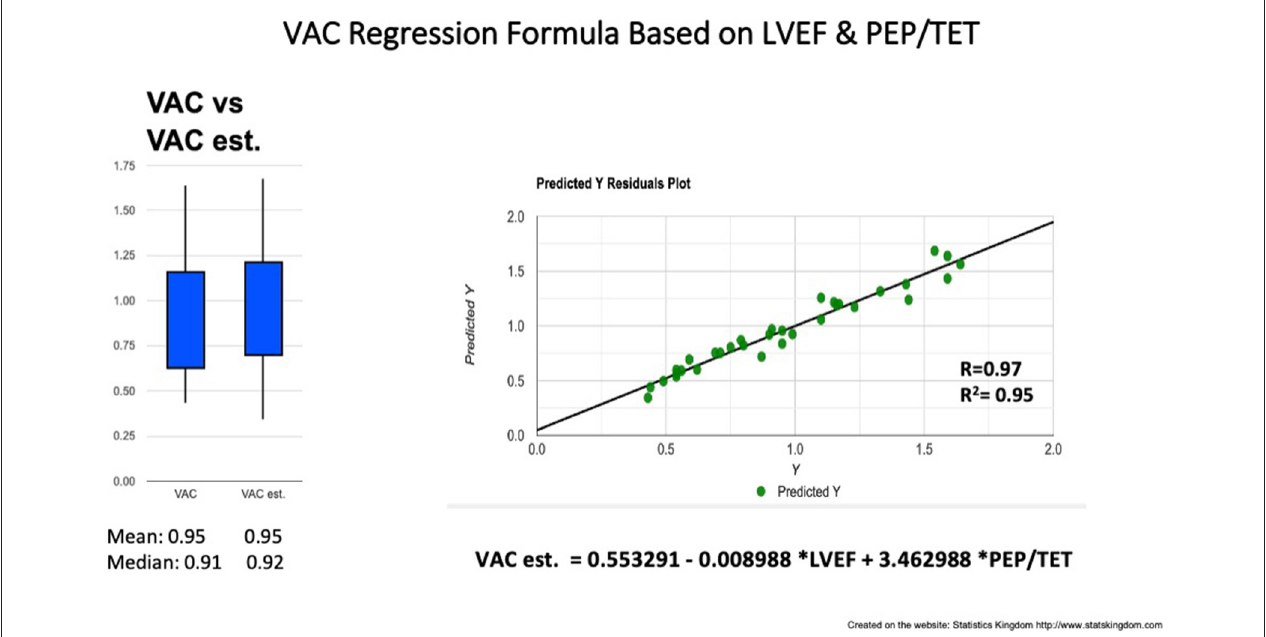
FIGURE 6 | VAC prediction by multiple regression formula based on LVEF and PEP/TET. Left: Box plot comparison between VAC and estimated (est.) VAC; Right: Correlation line VAC to VAC est. VAC ventriculo-arterial coupling, LVEF left ventricle ejection fraction, PEP pre-ejection period, TET total ejection fraction.